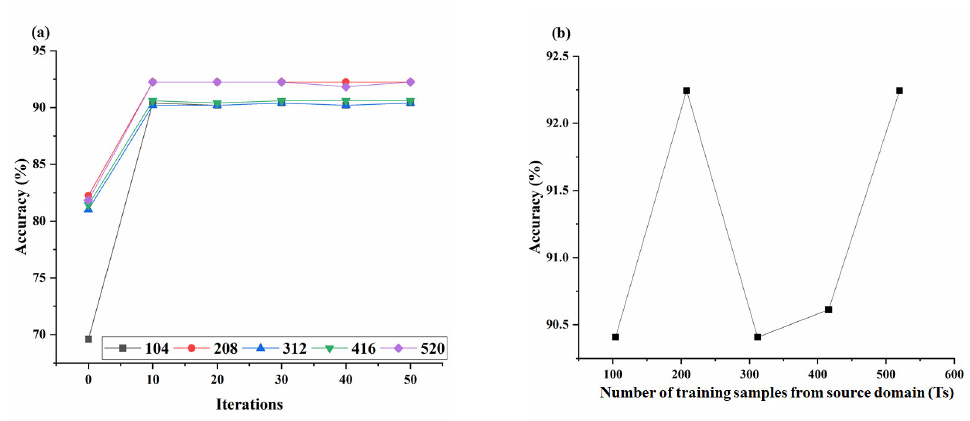
Figure 7. ( a ) The overall classification accuracies of TrAdaBoost based on SVM with different parameter settings of N and Ts. ( b ) shows the effect of the Ts on overall accuracy.